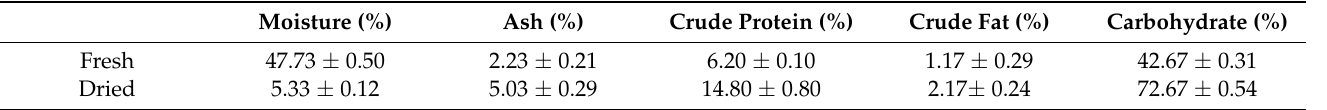
Table 1. The composition of fresh and dried C. osmophloeum leaves a . Moisture (%)